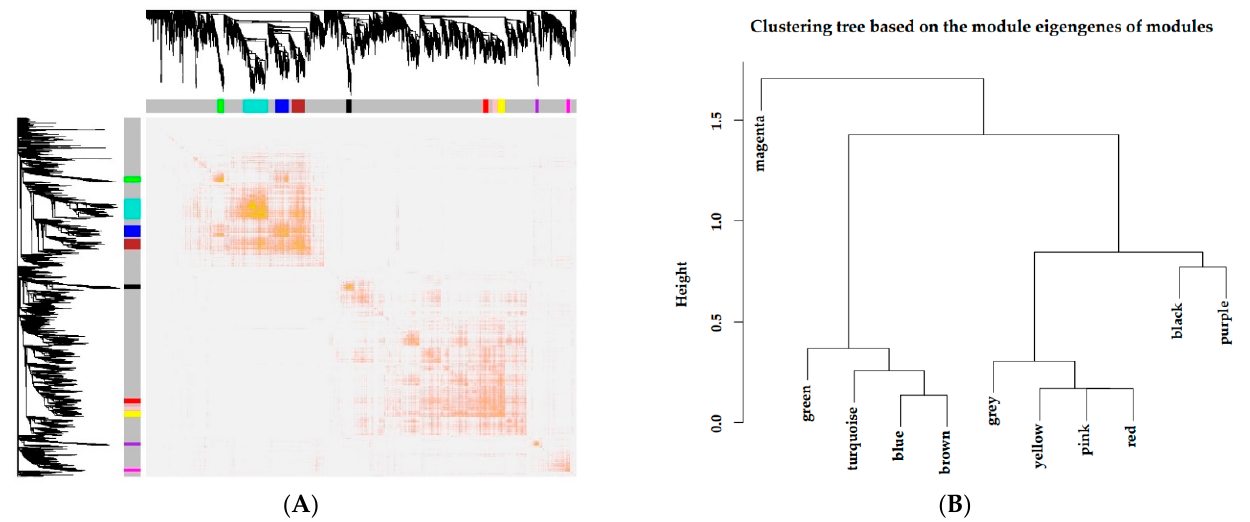
Figure 4. Independence inspection of gene coexpression modules. ( A ) Topological overlapping heat map. Both rows and columns in the figure represented the single gene. Light color indicated low overlap, and dark red indicated high overlap. ( B ) Correlation clustering of expression matrix gene coexpression modules.